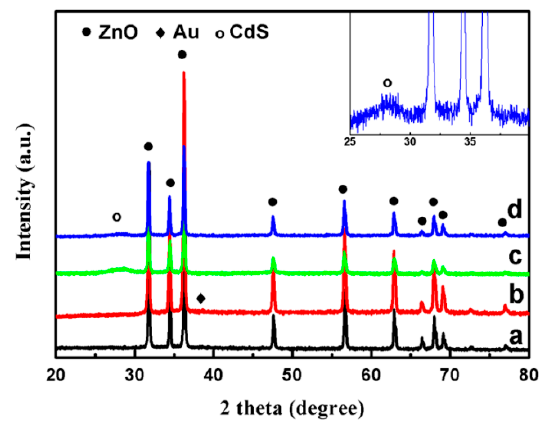
Figure 1. XRD patterns of ( a ) ZnO; ( b ) ZnO/Au; ( c ) ZnO/CdS; and ( d ) ZnO/Au/CdS samples. Inset: magnification images of a portion of the XRD pattern.